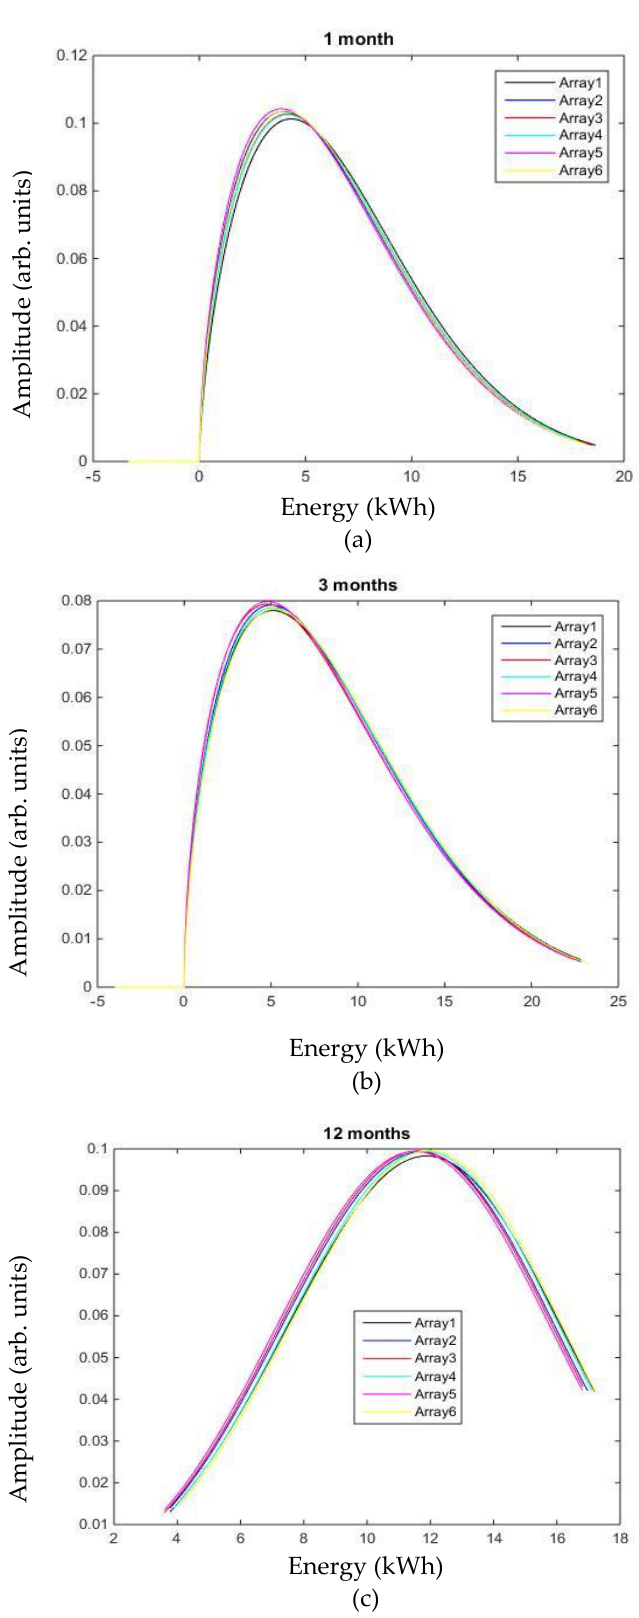
Figure 4. Pearson probability density functions for different periods: ( a ) monthly; ( b ) quarterly; ( c ) yearly.